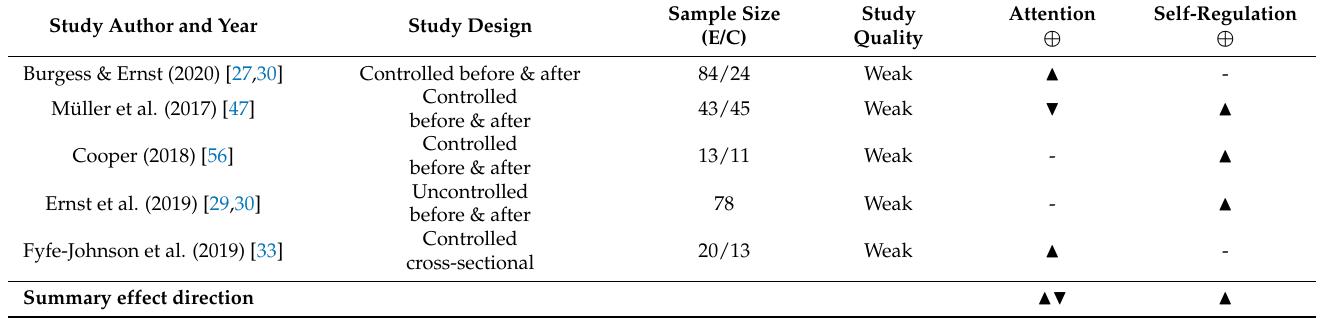
Table 4. Effect direction plot for nature-based ECE vs. traditional ECE on cognitive